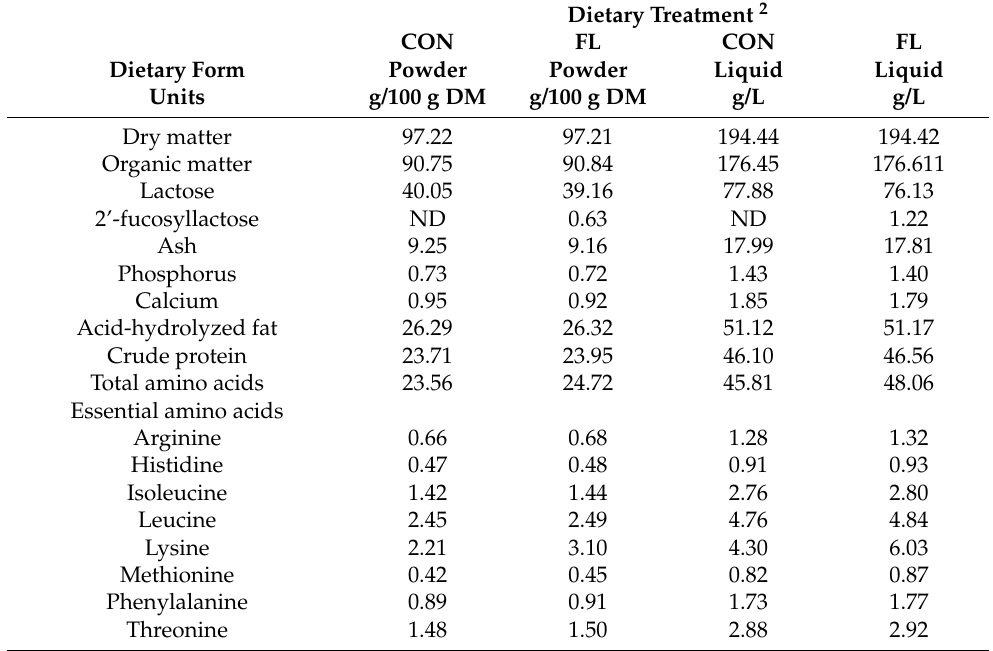
Table 1. Nutritional composition of experimental pig milk replacer treatments 1